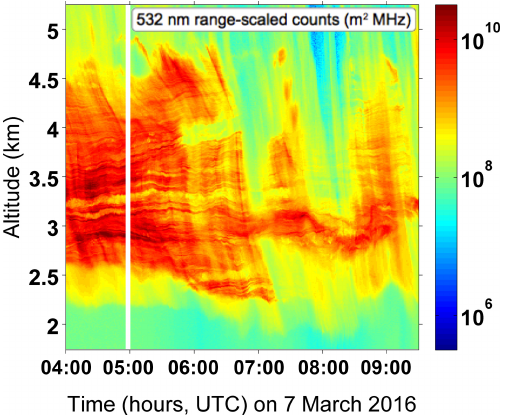
Figure 1. Thin laminated layers within an Arctic cloud. 532nm range-scaled counts from the CRL lidar at Eureka, Nunavut, show- ing quasi-horizontal layers as thin as 7.5m each within a cloud on 7 March 2016 during snowing conditions.